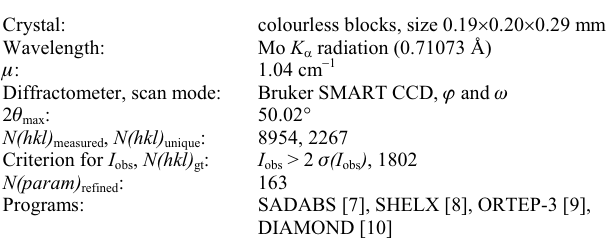
Table 1. Data collection and